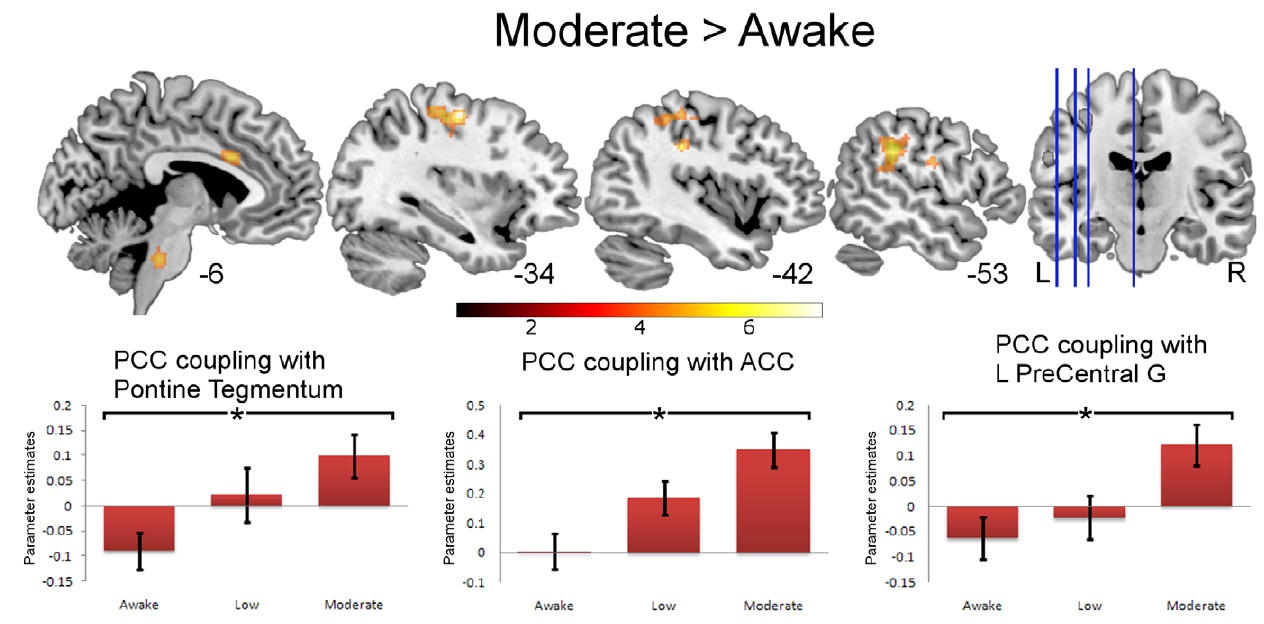
Figure 2. Significant PCC connectivity for Moderate . Awake sedation shown superimposed on a standard T1 weighted structural image. * in the plots denotes connectivity that survived a random field cluster threshold of p # 0.05 corrected for the entire brain (at voxel p # 0.001 uncorrected). Error bars show standard error. Talairach and Tournoux x coordinates shown underneath the T1 weighted brain slices. The color bar indicates strength of connectivity (t score). doi:10.1371/journal.pone.0014224.g002 PLoS ONE |